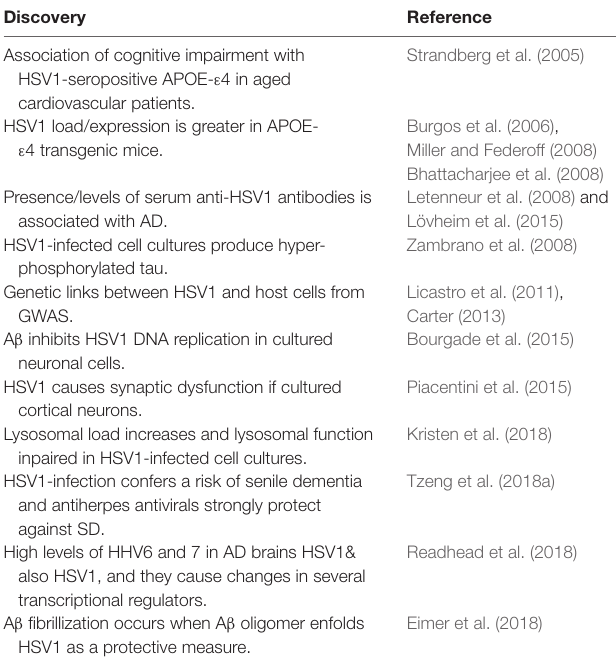
TABLE 2 | Some major discoveries relating to HSV1 and AD between 2005 and